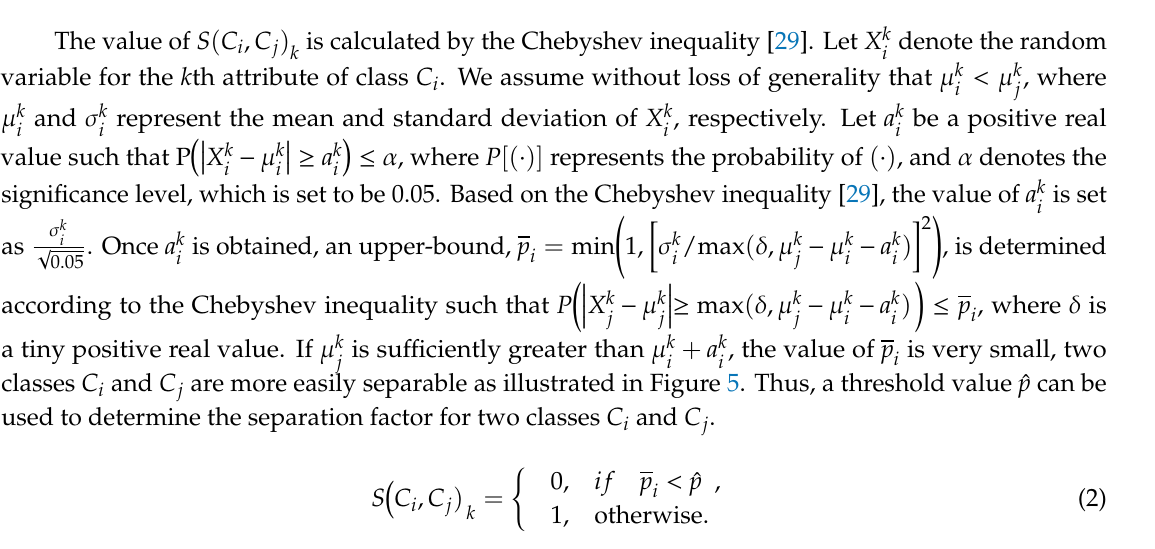
C are not separable. j